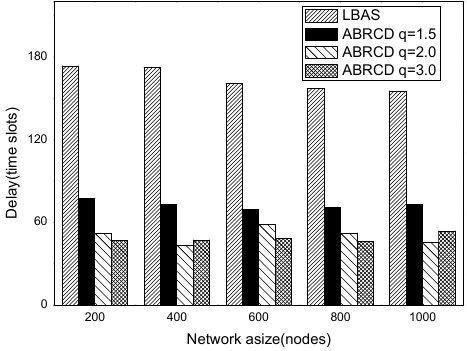
Figure 43. The impact of network size with fixed | T | = 20 on delay.